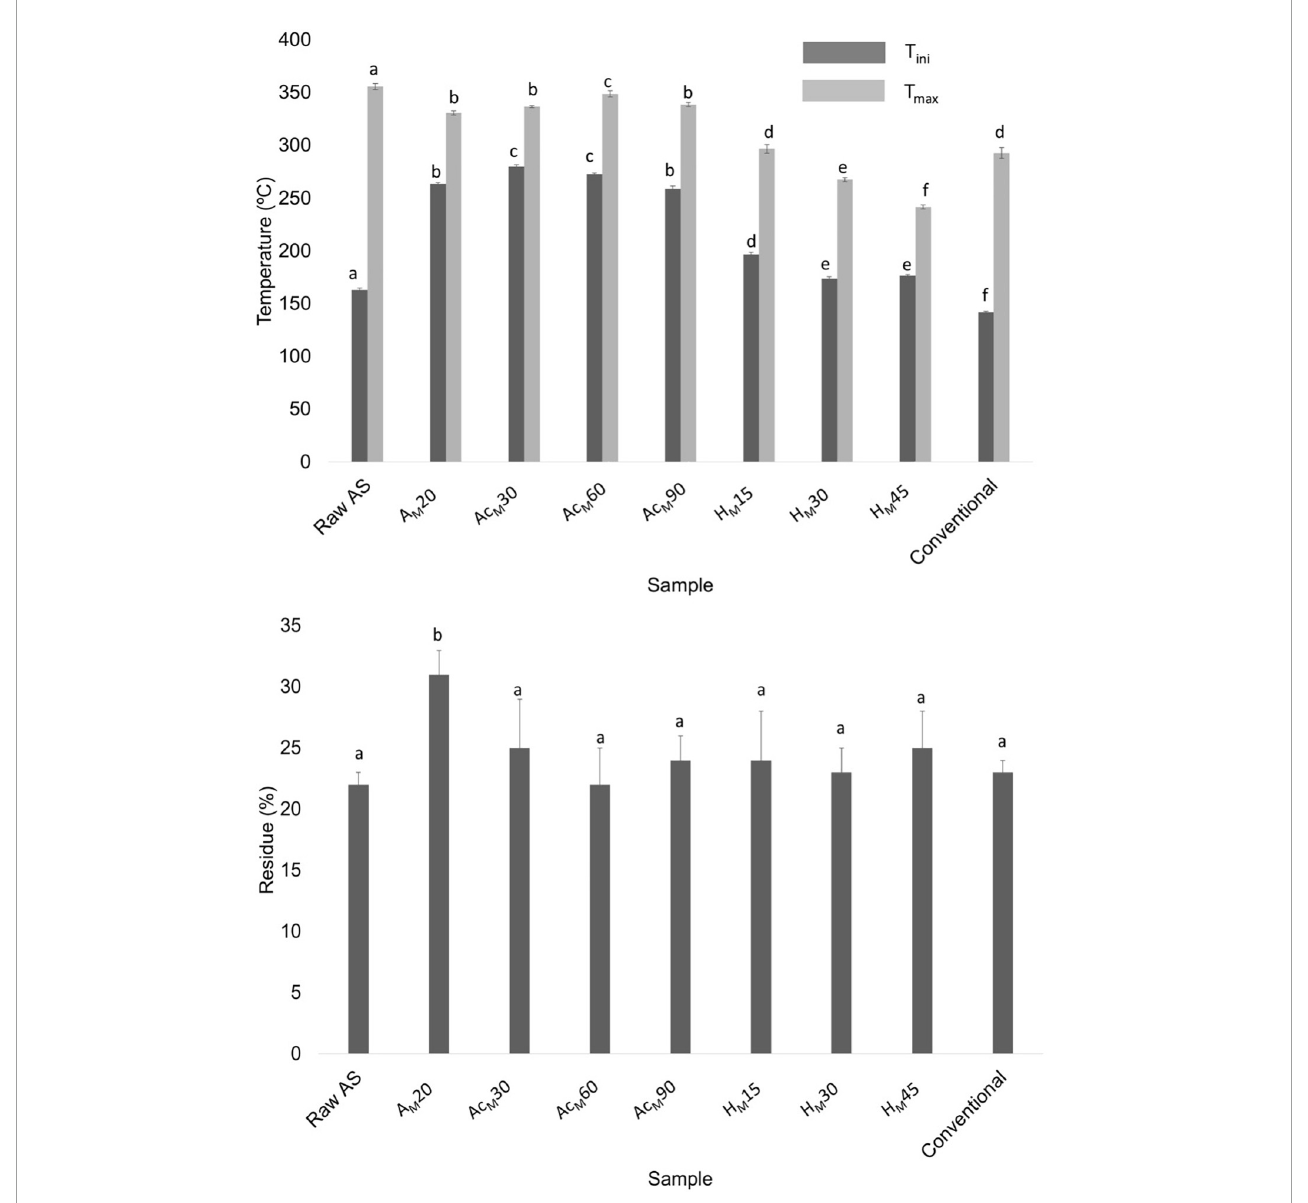
FIGURE7 Thermal parameters obtained for raw AS; alkalized sample by MAE for 20 min (A M 20); acetylated A M 20 sample for 30, 60, and 90 min (Ac M 30, Ac M 60, and Ac M 90, respectively), acid-hydrolyzed A M 20 sample for 15, 30, and 45 min (H M 15, H M 30, and H M 45, respectively); and CNCs obtained using the conventional procedure (conventional). Mean ± SD, n = 3. Different superscripts within the same parameter indicate statistically significant different values ( p <